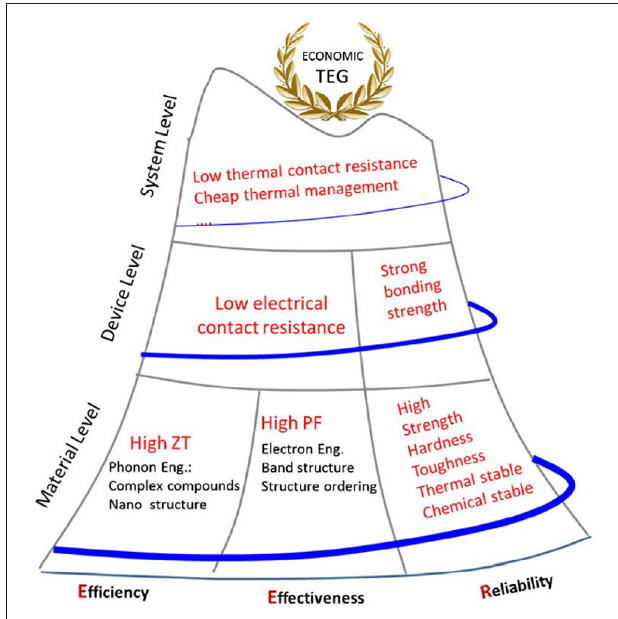
FIGURE 16 | Hierarchical requirements for TEG: the efficiency–effectiveness–reliability mountain. Reprint from Liu W. et al.